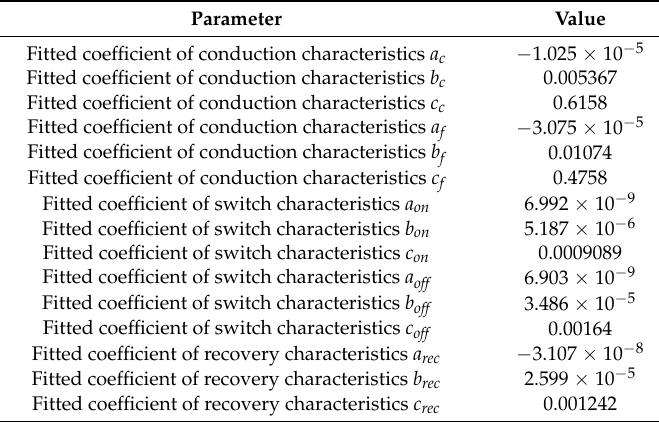
Table 2. Fitting coefficients of Si-IGBT modules.